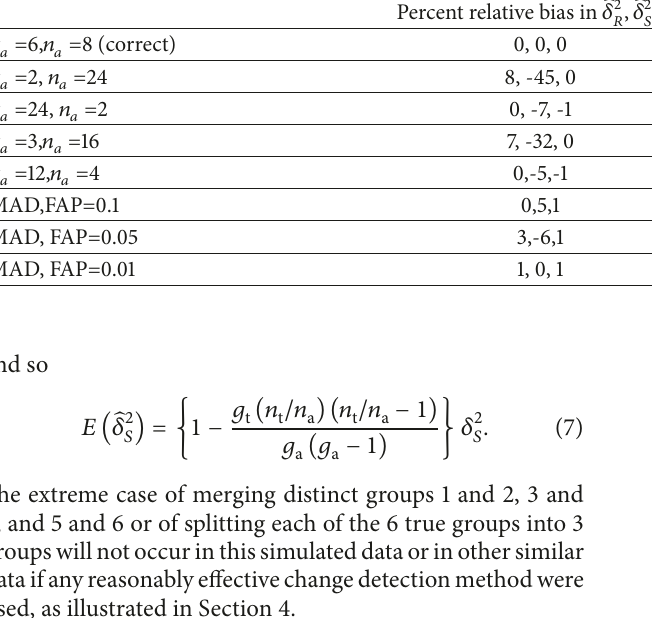
̂𝛿 2 , ̂𝛿 2 , ̂𝛿 2 𝑅 𝑆 𝑇 for several values of 𝑔 =3, 𝑛 =16 agree with that predicted by (6) for merging successive groups, and the Percent relative bias in